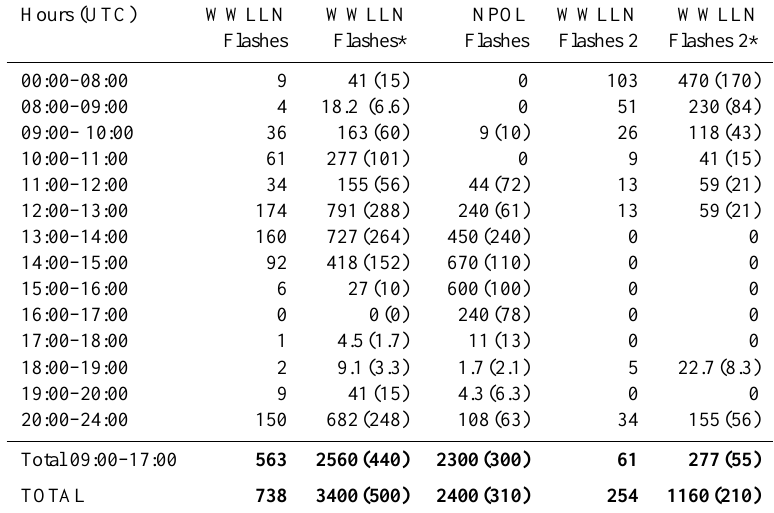
Table 2. Flashes detected by the World Wide Lightning Location Network (WWLLN Flashes), estimated flashes using the WWLLN detected flashes and the network flash detection efficiency (WWLLN Flashes*), and flashes calculated from radar heights estimated by the NPOL radar (uncertainties in parenthesis) near the Gulf of Panama on 5 August 2007. WWLLN Flashes 2 refer to flashes detected in the region upwind of the DC-8 spiral on 5 August 2007. See text for details of